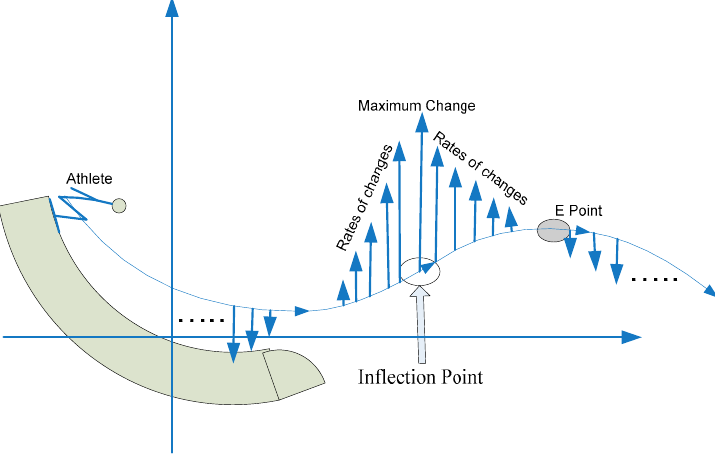
Figure 1. The movement of an athlete on the ski ‐ jump ramp and the rates of change.